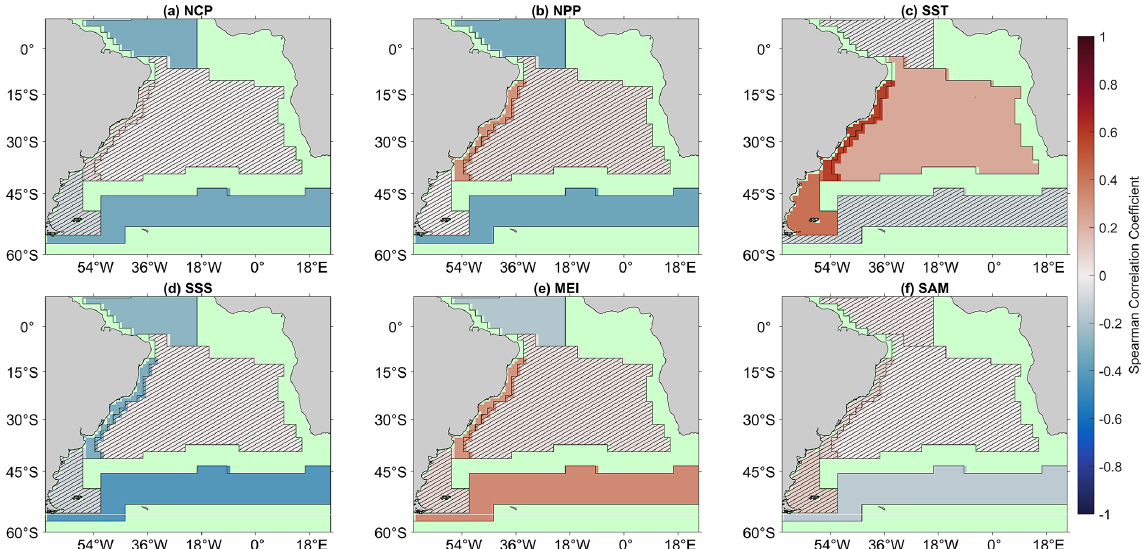
Figure A2. Spearman correlations between the in situ (cid:49)p CO 2 inter-annual component of the X-11 analysis and (a) net community pro- duction (NCP), (b) net primary production (NPP), (c) sea surface temperature (SST), (d) sea surface salinity (SSS), (e) multivariate ENSO index (MEI), and (f) Southern Annular Mode (SAM) inter-annual components on a per province basis. Hashed areas indicate no significant correlations, and green regions indicate no analysis was performed due to missing